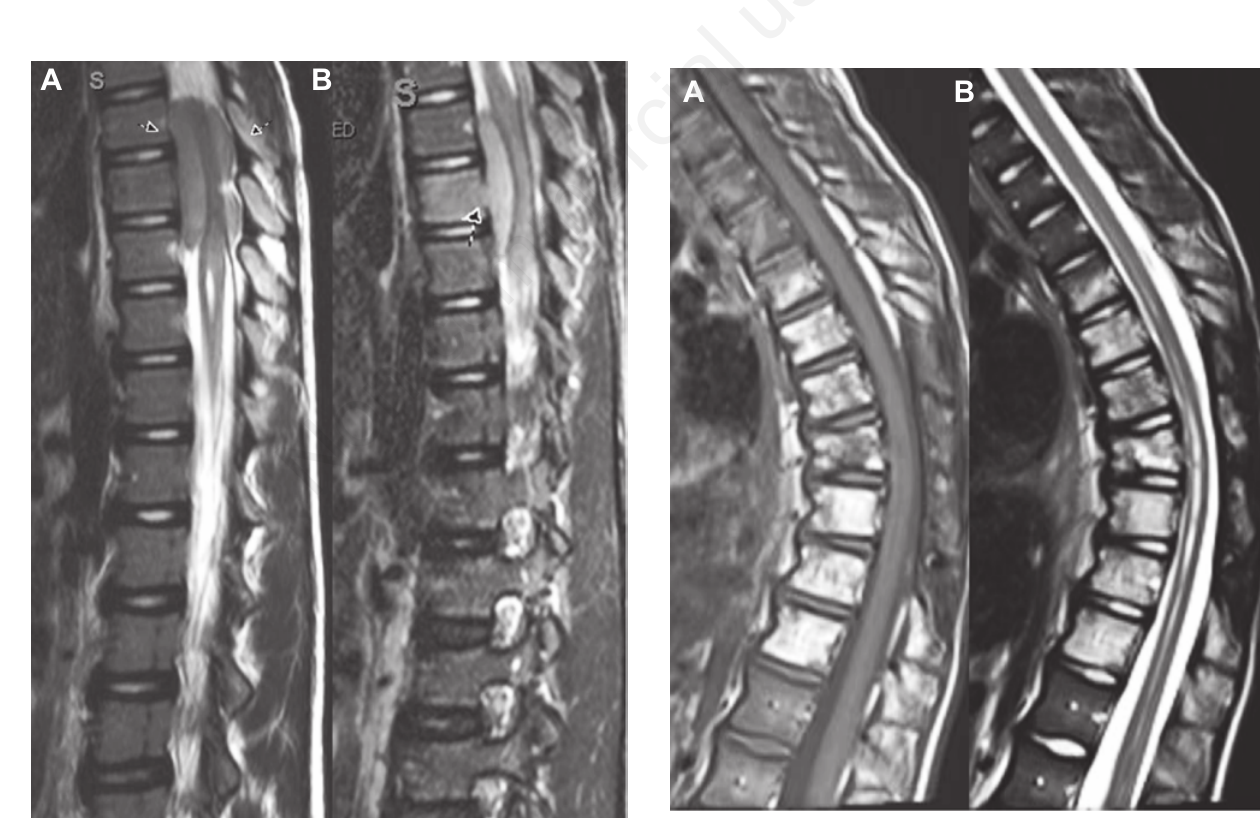
Figure 1. Sagittal T2-weighted magnetic resonance images (A,B) through the mid thoracic spine shows a homogenous circumfer- ential epidural mass compressing the spinal cord. The second image (B; arrow) shows posterior cortical disruption of the T8 body with marrow signal changes. The final pathology was con- sistent with Ewing sarcoma.